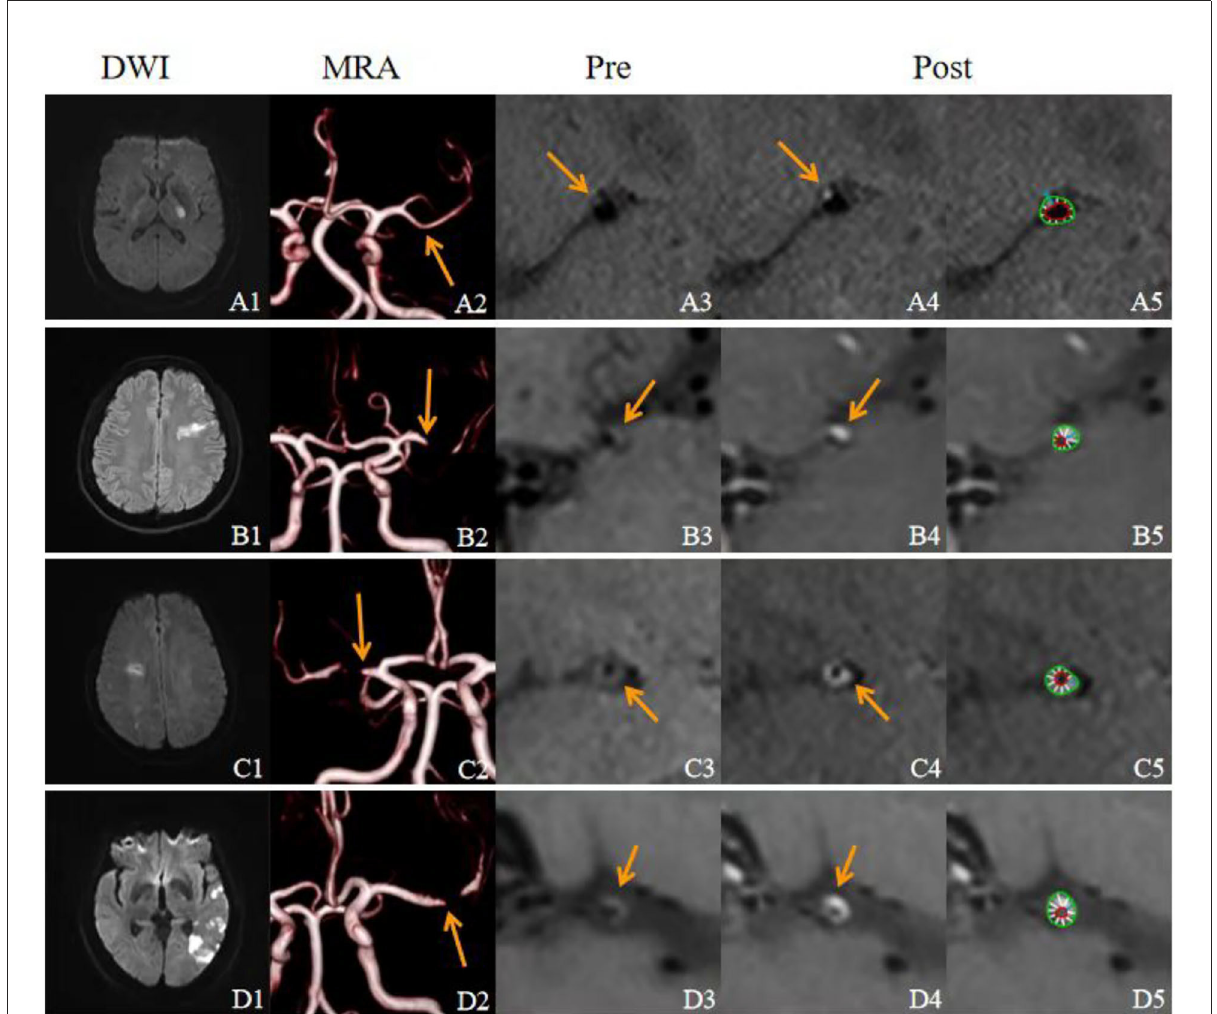
FIGURE4 Characteristics of the culprit plaque in the M1 segment of the MCA in four patients with acute stroke with different mechanisms. (A1–A5) , A 39-year-old male, diffusion-weighted images (DWIs) (A1) showed high signal intensity in the left basal ganglia, and the stroke mechanism was parent artery atherosclerosis occluding penetrating artery by MCA atherosclerosis. Magnetic resonance angiography MRA_ (A2) showed that the left MCA M1 lumen was normal (arrow). Sagittal images of the precontrast (A3) and postcontrast (A4) HR-VWI showed that the plaque was located in the upper wall (arrow), showed mild enhancement, and the inner and outer walls of vessels were semiautomatically delineated on postcontrast HR-VWI (A5) . (B1–B5) A 48-year-old male, DWI (B1) showed multiple hypersignals in the left frontal cortex and the subcortical area, and an artery-to-artery embolism was considered the mechanism of stroke; MRA (B2) showed that the left MCA M1 lumen was severely stenotic (arrow); (B3,B4) HR-VWI showed that the plaque was located in the upper wall, which showed obvious enhancement (arrow). (C1–C5) , A 53-year-old male, DWI (C1) showed multiple hypersignals in the right subcortical watershed, and the mechanism of stroke was considered when evaluating the mechanism of hypoperfusion. MRA (C2) showed that the right MCA M1 lumen was severely stenotic (arrow). (C3,C4) HR-VWI showed that the plaque was located in the posterior wall, which showed obvious enhancement (arrow). (D1–D5) , A 60-year-old male, DWI (D1) showed multiple hypersignals in the left temporal lobe and the left posterior cortical watershed area; MRA (D2) showed that the left MCA M1 lumen was severely stenotic (arrow); (D3,D4) HR-VWI showed that the plaque was located in the posterior wall, which showed obvious enhancement